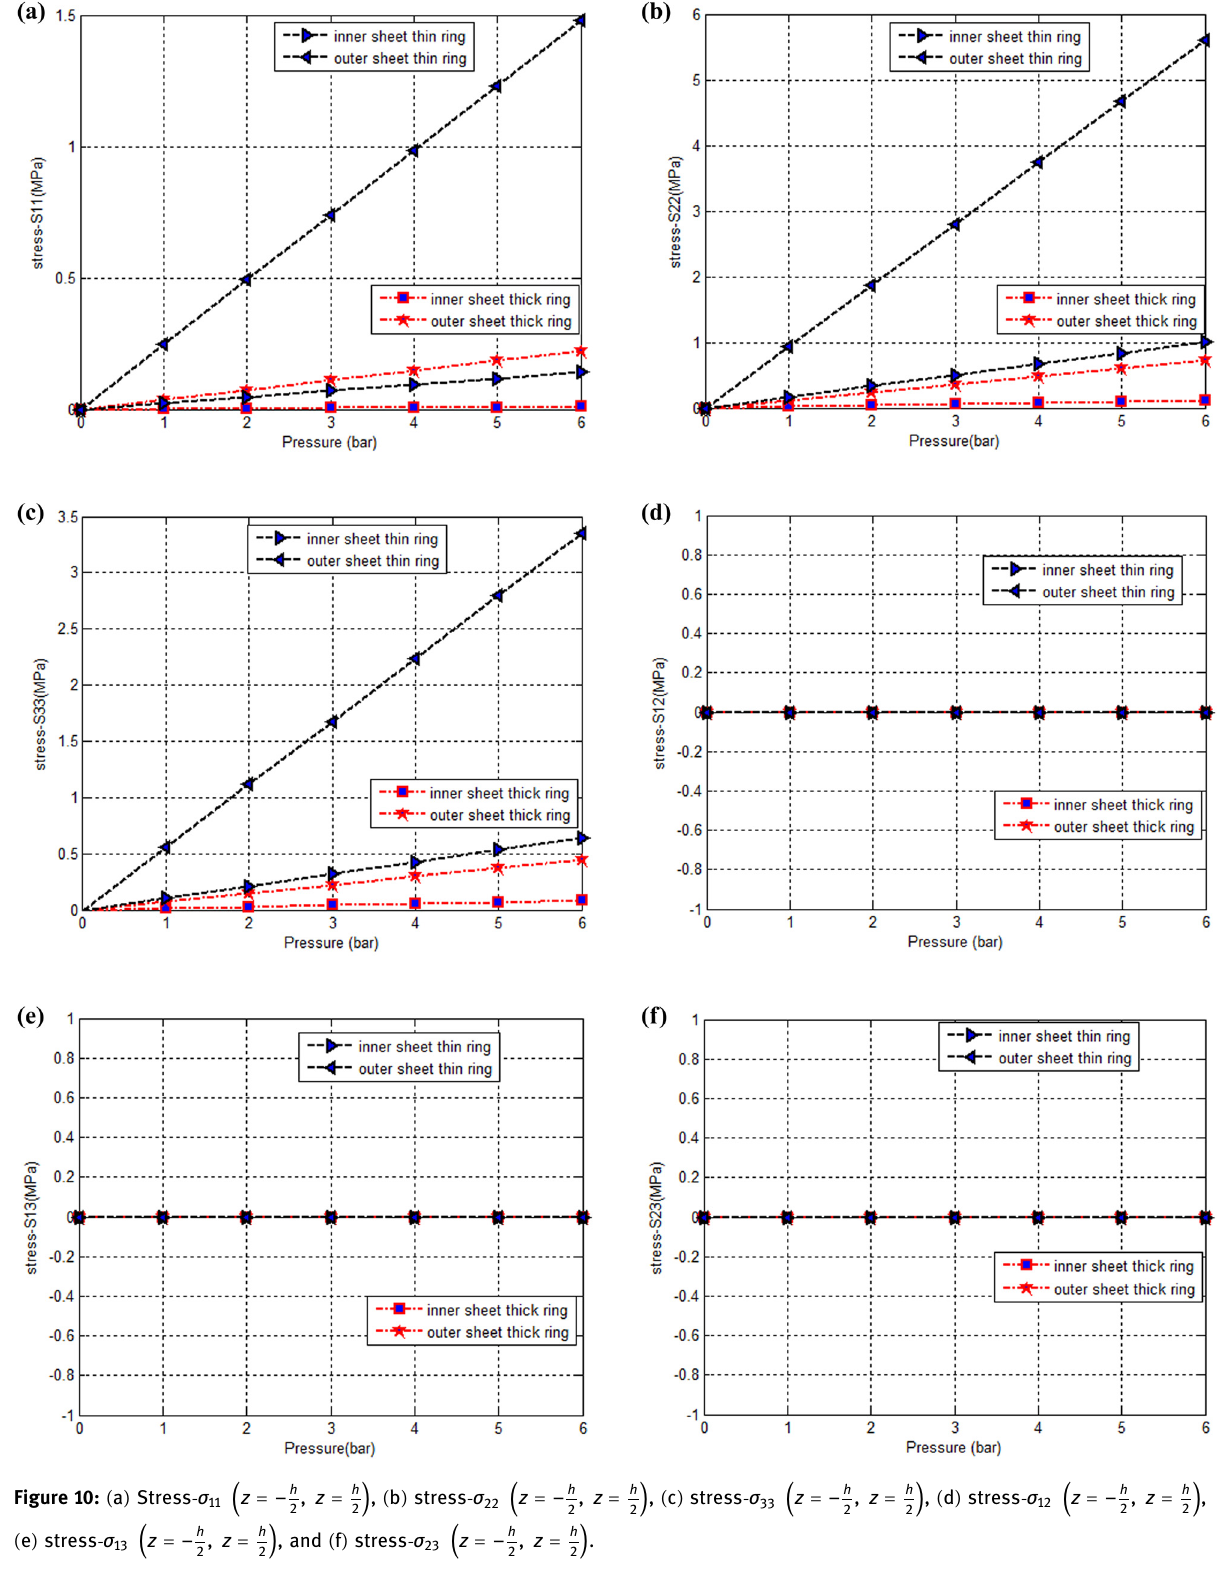
Figure 10: ( a ) Stress -